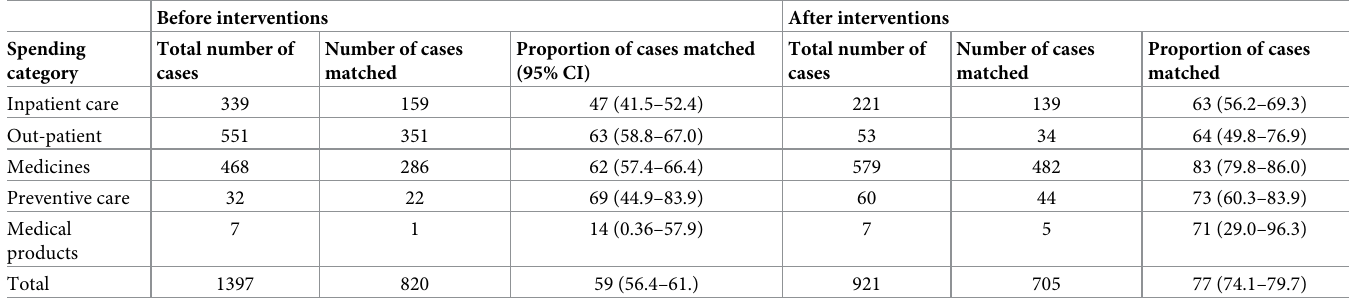
Table 4. Proportion of clients at provider correctly linked with household information before and after intervention and by type of service provided. Before